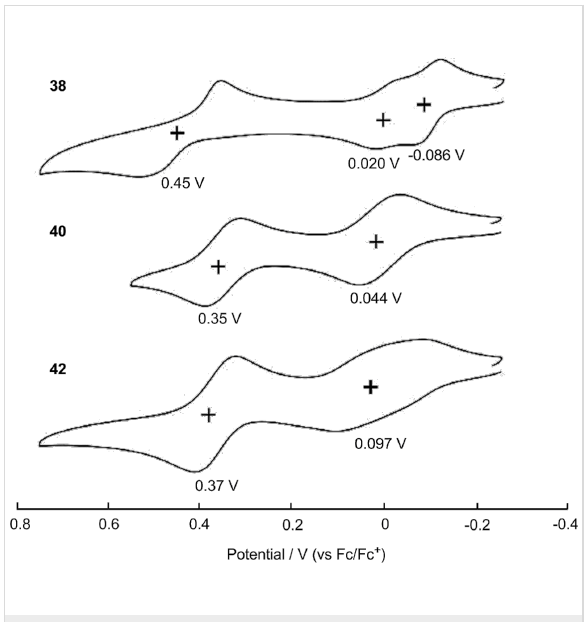
Figure 14: Cyclic voltammograms of 38 , 40 , and 42 (0.1 mM) in benzonitrile with 0.1 M n -Bu 4 PF 6 as a supporting